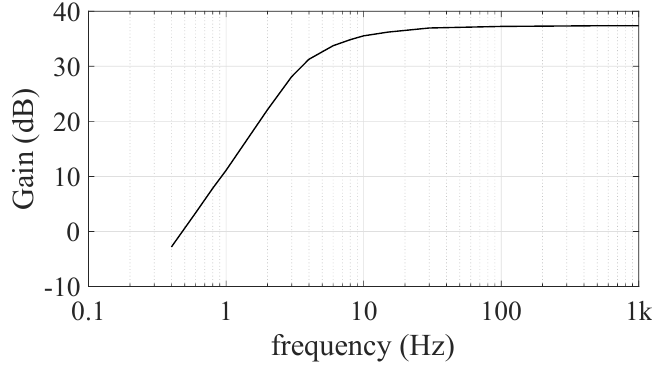
Figure 26. PFGA low frequency